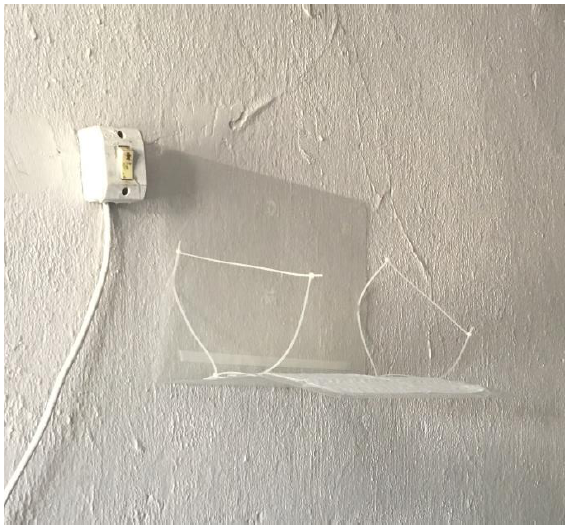
Figure 2. EDC. Limeira, 2019.